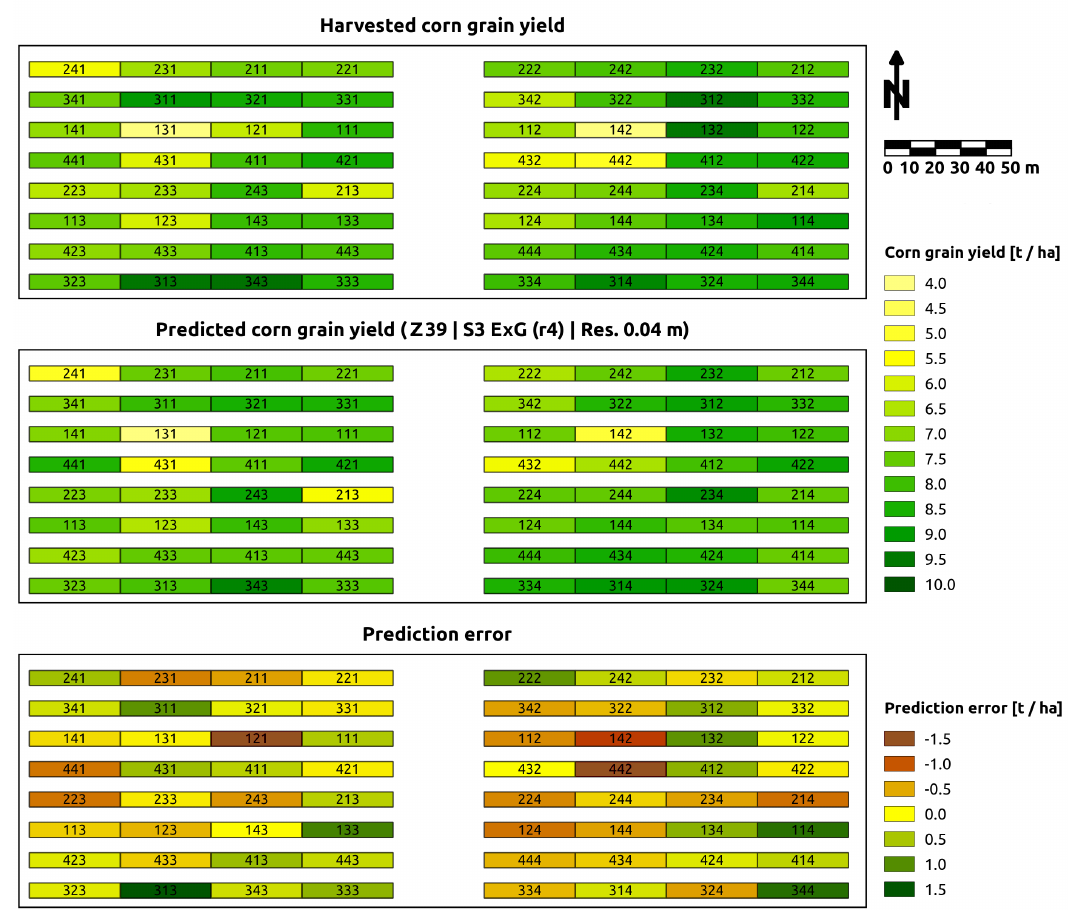
Figure 6. Spatial illustration of plot-wise distribution of harvested corn grain yield ( top ), corn grain yield predicted by strategy S at crop growth stage Z39, with ExG at Ridler 3 threshold r and an aerial image ground resolution of 0.04 m · px − 1 ( middle ) and the resulting 4 prediction error of this strategy ( bottom ). For this strategy, the total root mean squared error of prediction (RMSEP) equals 0.68 t · ha − 1